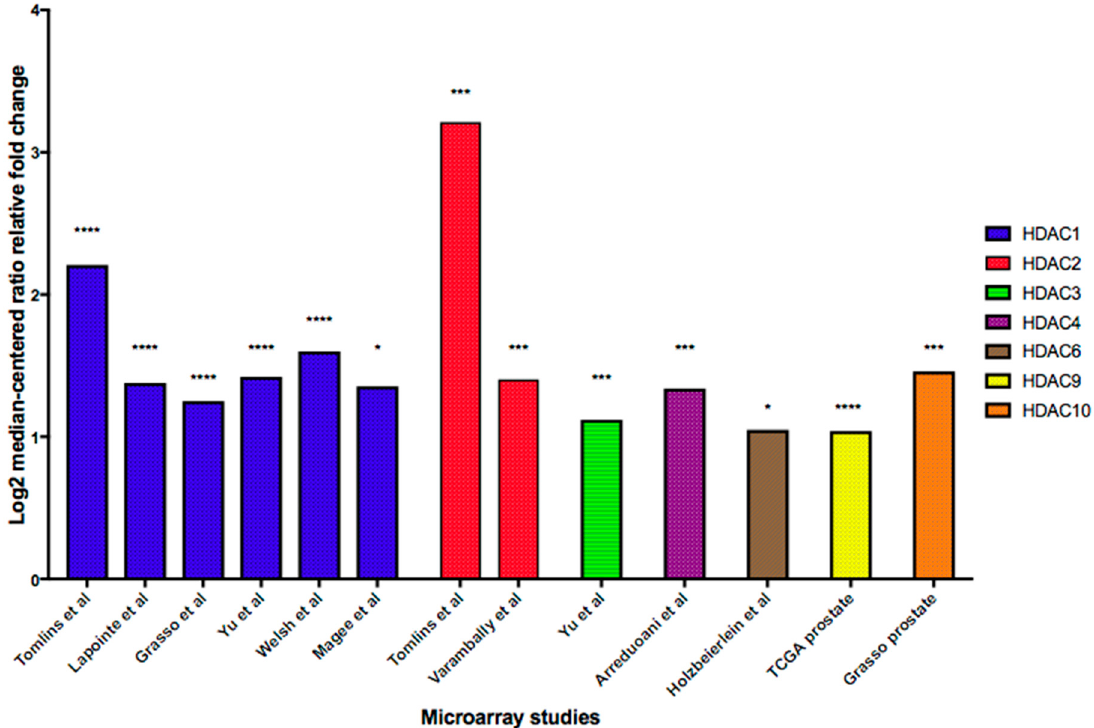
Figure 3. Summary graph of microarray analysis of HDACs from the Oncomine database. The relative-fold change represents the difference in the respective HDAC between prostate carcinoma and normal prostate gland. * p -value < 0.05, *** p < 0.001 and **** p < 0.0001. This figure shows a summary of Supplementary Table S1.